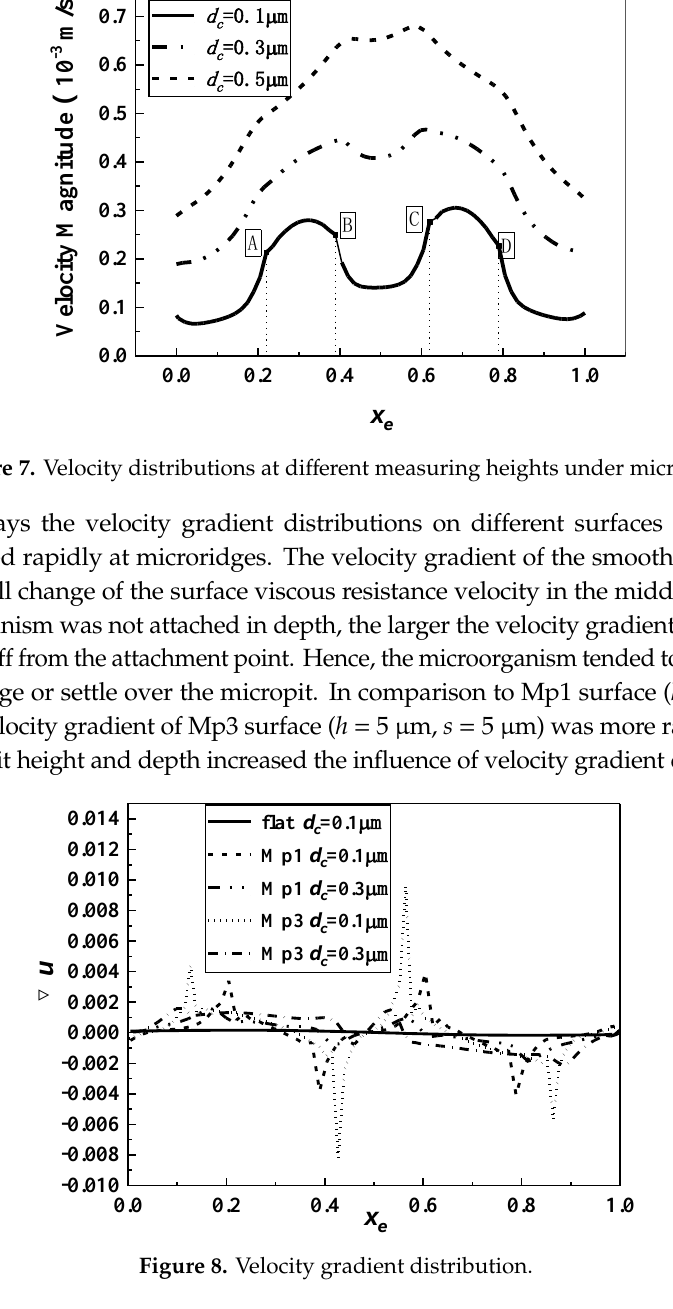
Figure 6. Velocity distribution on the microstructural surface with d c = 0.1 μm. The x e is normalized coordinates.